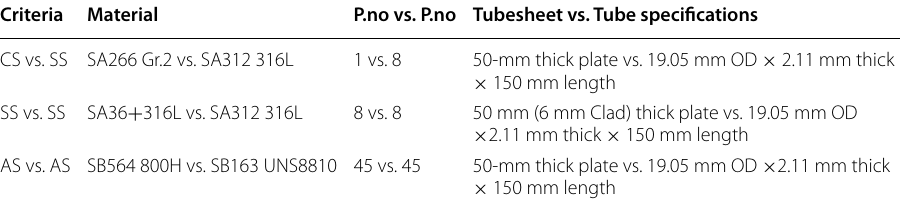
Table 1 Specifications, criteria, and P.no of base material Criteria